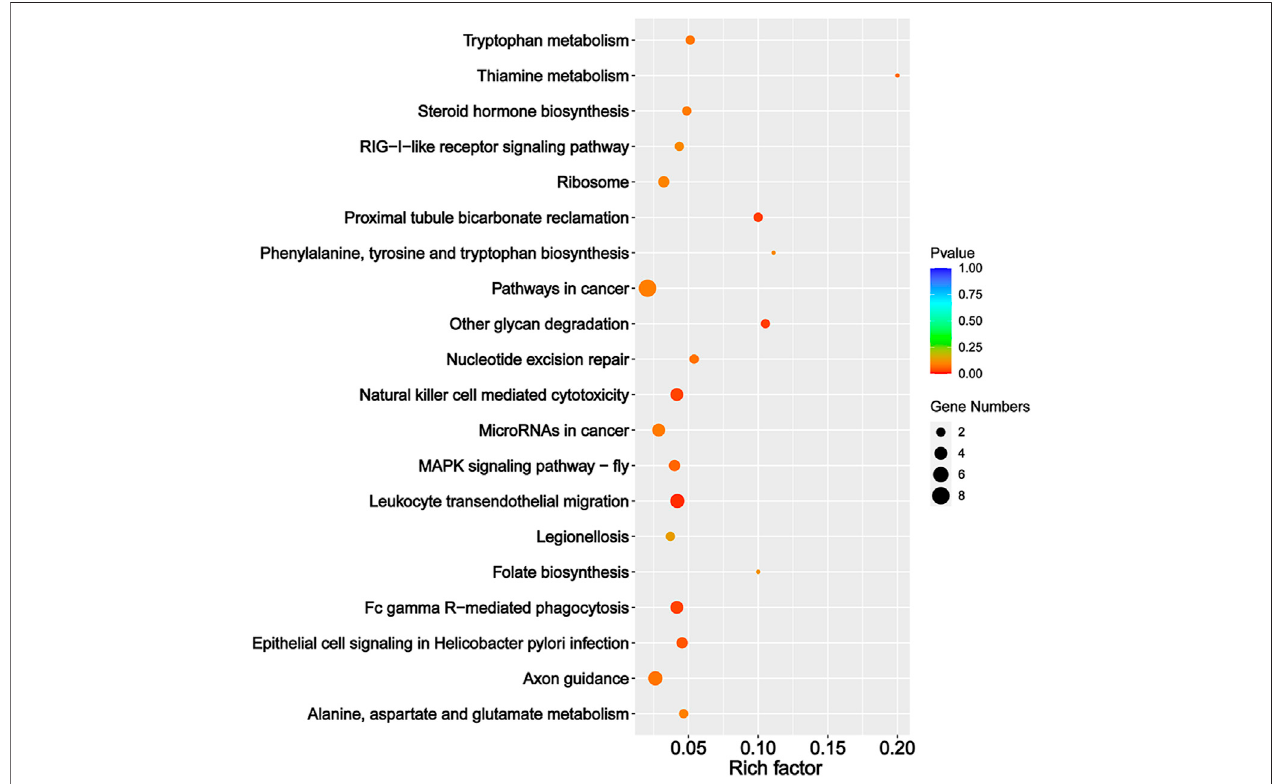
FIGURE 5 | The 20 most enriched KEGG pathways of the predicted target genes of sex-biased differentially expressed miRNAs (ovaries relative to testes) in summer.